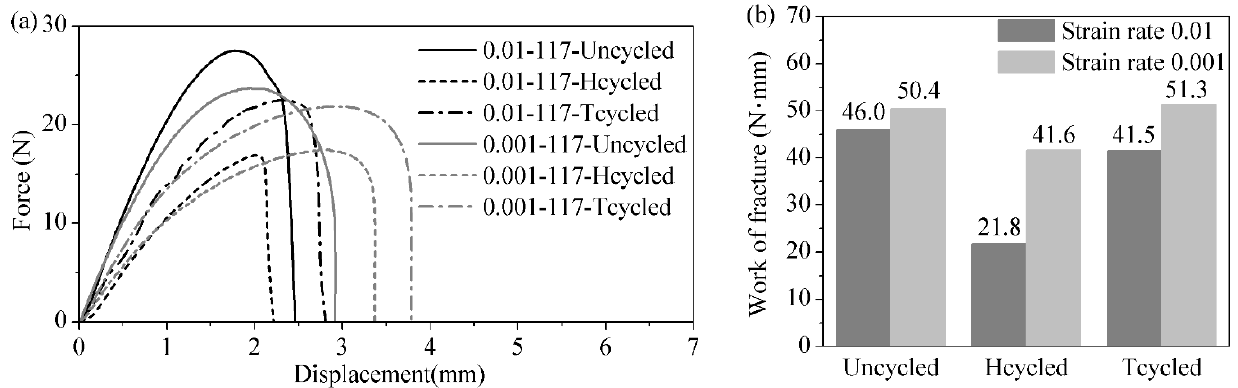
Figure 4. ( a ) The force-displacement curves of N117 DDENT with L = 10 mm under different strain rates (0.01 s −1 and 0.001 s −1 ) and different cycling treatments; ( b ) The work of fracture of N117 DDENT with L = 10 mm under different strain rates (0.01 s −1 and 0.001 s −1 ) and different cycling